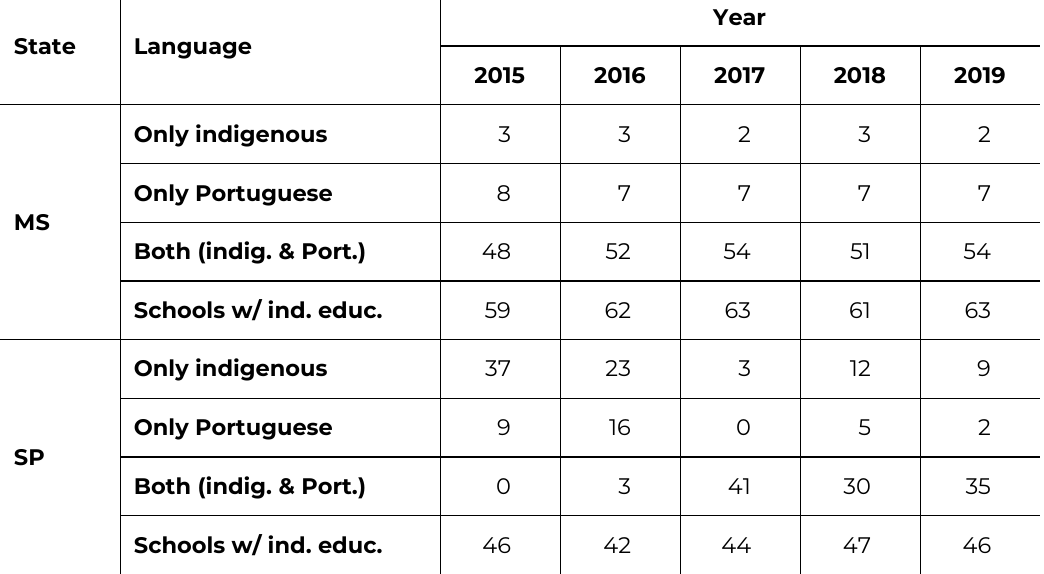
Table 5. Language used in the school